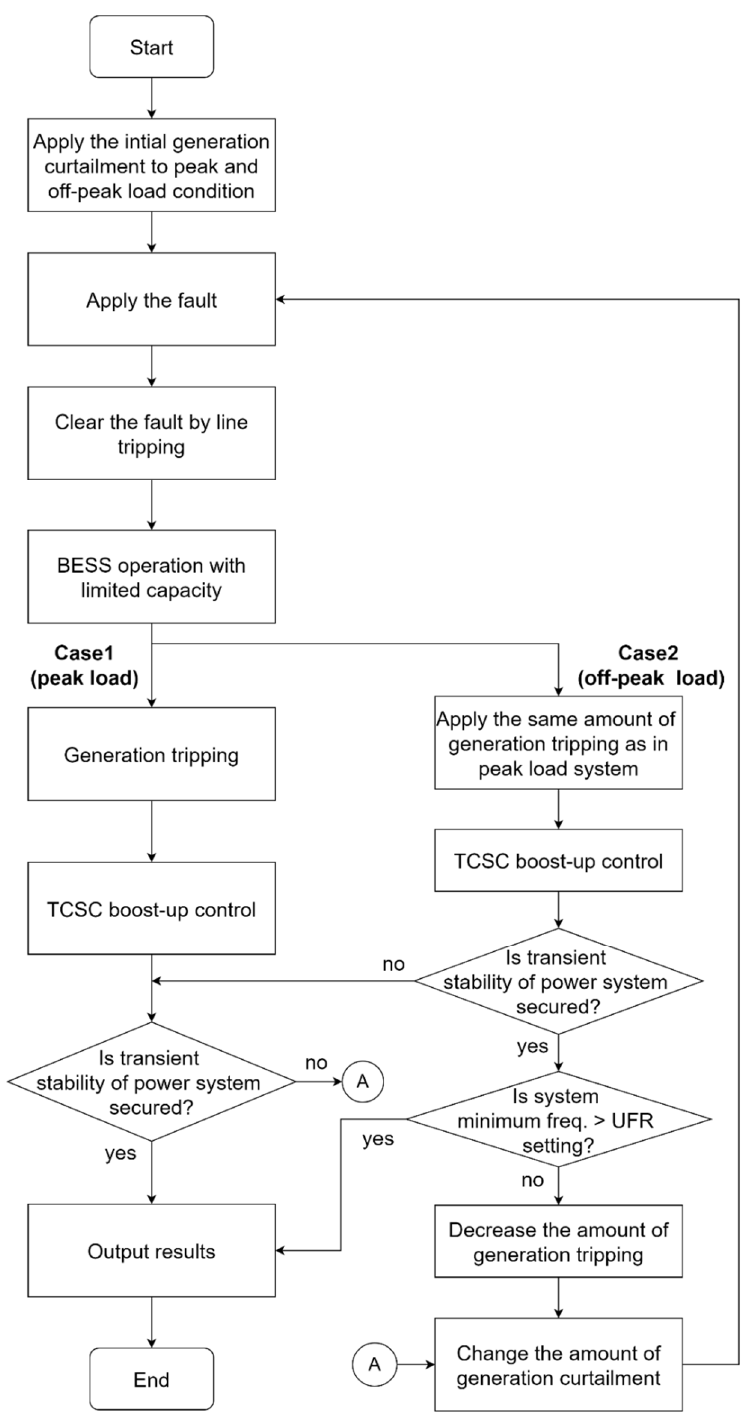
Figure 5. Evaluation procedure of generation curtailment relief using BESS.